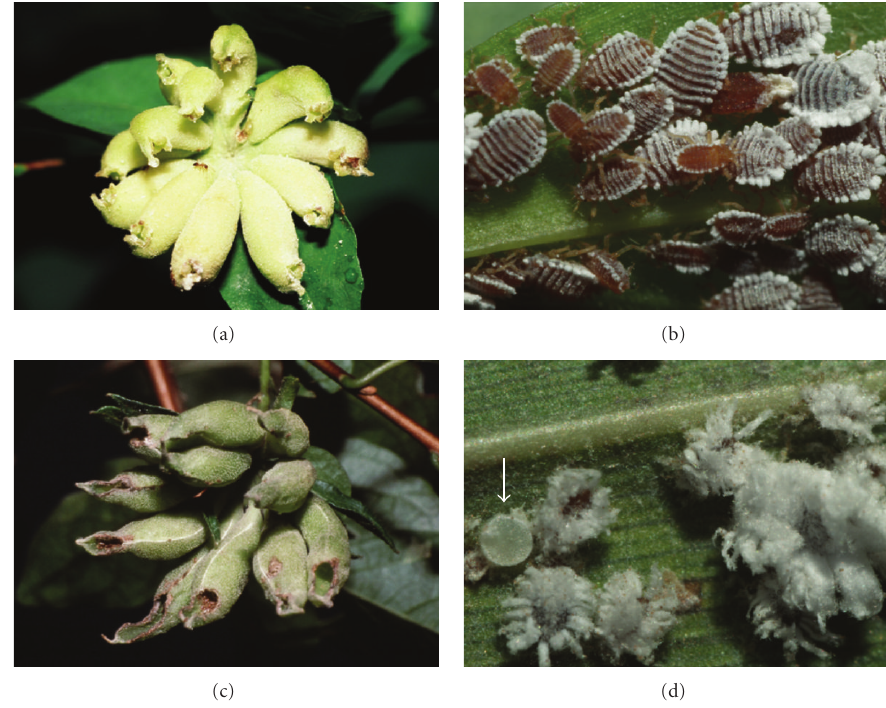
Figure 2: (a) A gall of Ceratovacuna nekoashi on Styrax japonicus (Seoul, South Korea; 3 August 1998). (b) A colony of C. nekoashi on the grass Microstegium vimineum (Niiza, Japan; 12 August 2009). (c) A gall of Ceratovacuna japonica on S. japonicus (Niiza; September 1990; photo by D. L. Stern). (d) A colony of C. japonica on the bambusoid Pleioblastus chino ; an egg of the predaceous lycaenid Taraka hamada (indicated by an arrow) is laid in the colony (Kumagaya, Japan; 24 October